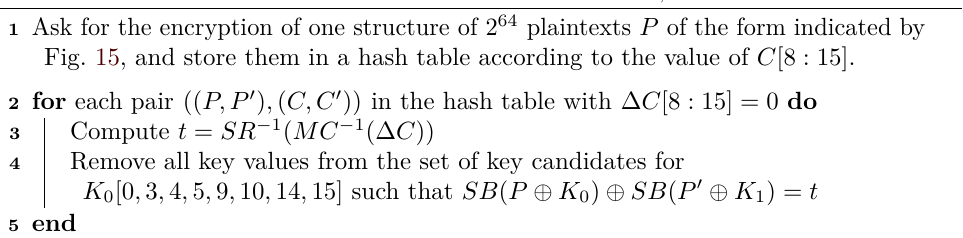
Algorithm 6: Impossible differential attack on AES-PRF 1 , 9 with one